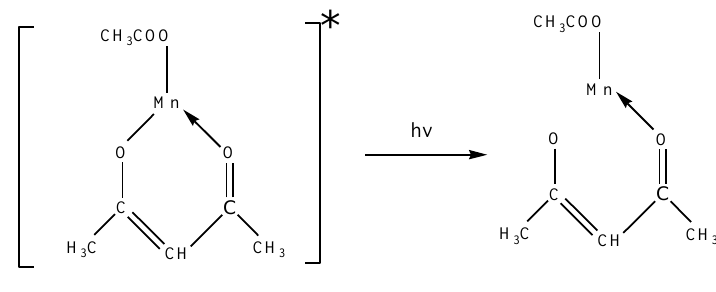
Scheme 3. Decomposition process of excited state.